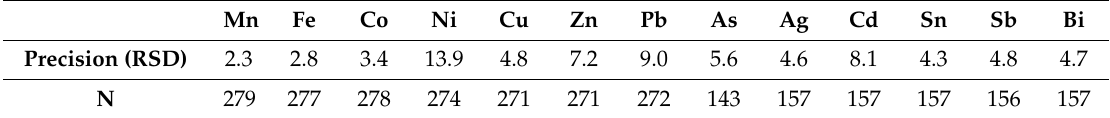
Precision of Mn, Fe, Co, Ni, Cu, Pb and Zn based on measurements of DING glasses (GOR132-G, KL2-G, StHs6-80-G, T1-G). Precision of Ag, Ag, Cd, Sn, Sb and Bi based